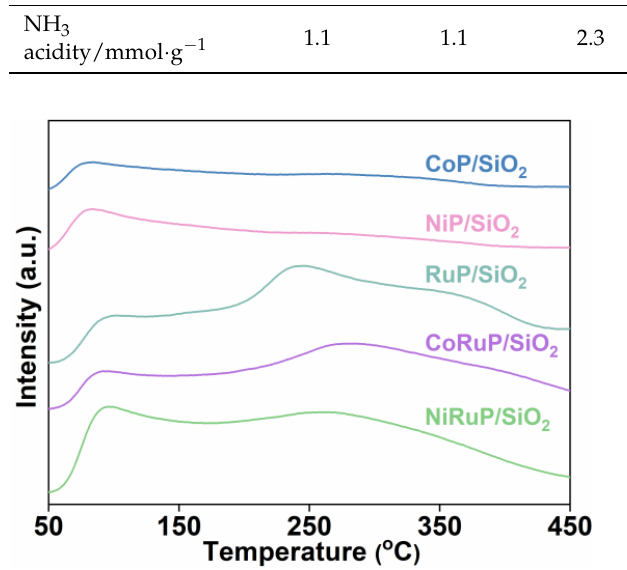
Figure 4. X-ray photoelectron spectrum of CoRuP/SiO 2 in ( a ) Co 2p and ( b ) Ru 3p regions. Table 2. Acid sites analysis by NH 3 -TPD.